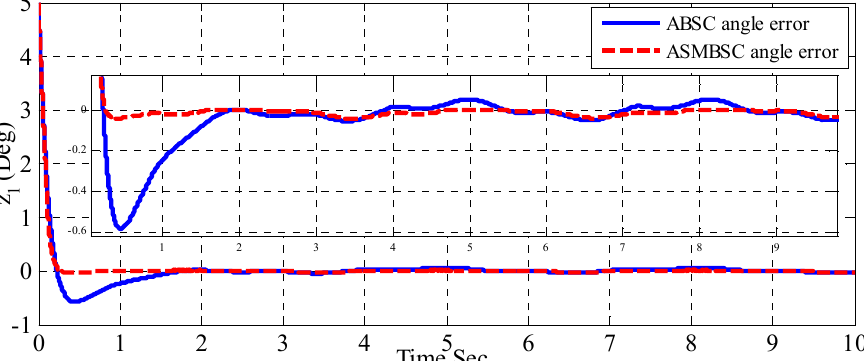
Figure 6. Error response of plate angular position based on adaptive backstepping and adaptive sliding mode backstepping controllers.